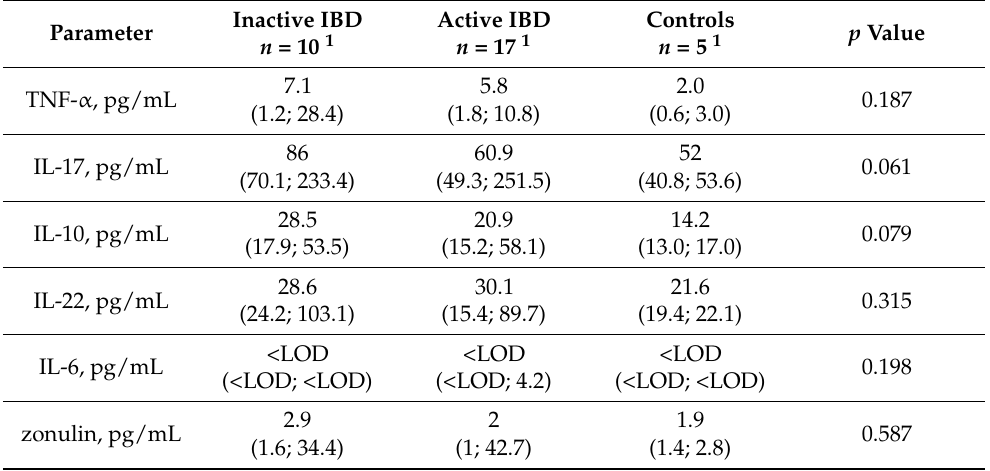
Table 7. Serum cytokine and zonulin levels in patients with inactive IBD, active IBD, and controls.